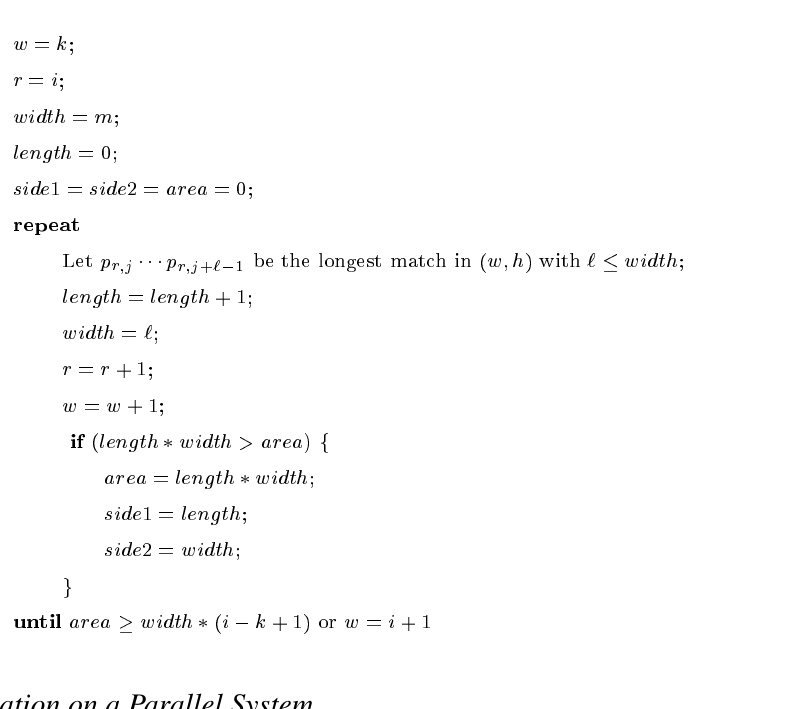
Figure 4. Computing the largest rectangle match in ( i, j ) and ( k, h )